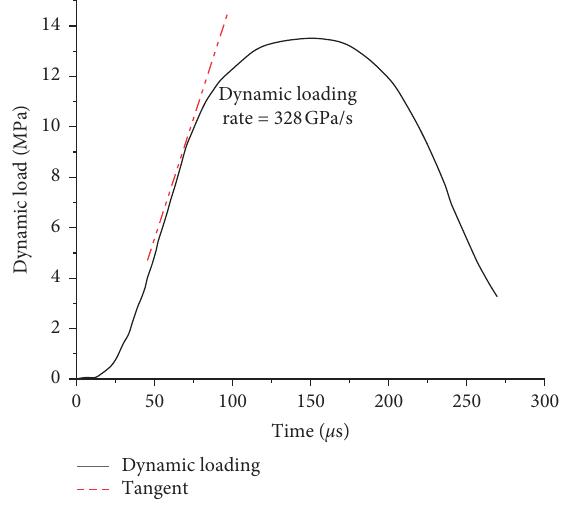
Figure 4: Dynamic load versus time